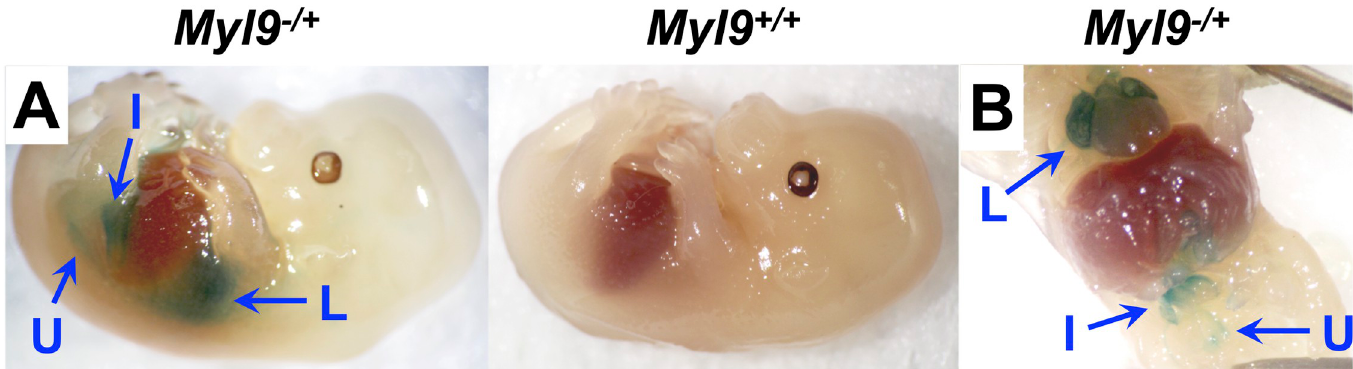
Fig 2. Myl9 promoter activity in the developing lung, intestine and urinary during embryogenesis. (A) Heterozygous Myl9 -/+ female mice were time-mated with wildtype Myl9 +/+ male mice, then embryos were harvested at gestational day E14.5. Whole embryo X-gal staining was performed to detect β -galactosidase activity as a reporter for the Myl9 gene. A representative Myl9 -/+ (LacZ reporter) and Myl9 +/+ (control) pair of embryos is shown. (B) The thoracic and abdominal cavities of a Myl9 -/+ embryo was exposed following whole embryo X-gal staining. L = lung; I = intestine; U = urinary tissue.